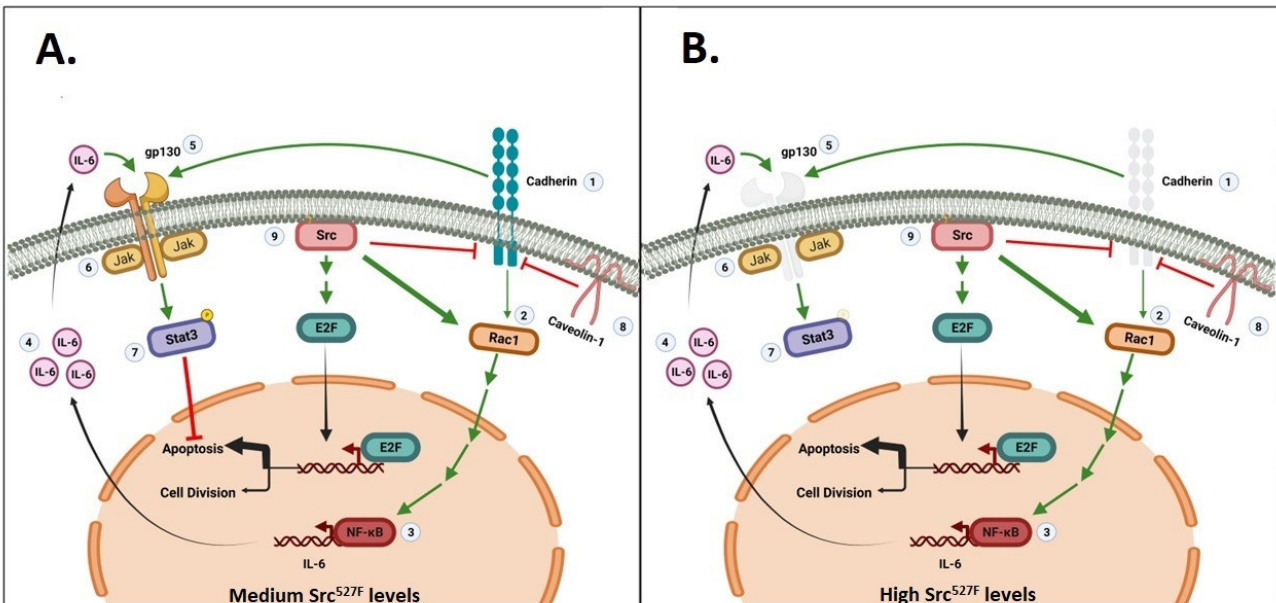
Figure 1. The engagement of cadherins from opposing cells increases Rac and Stat3 activity and is required for Src-mediated Stat3 activation and cellular survival (data from [48]). Engagement of cadherins (1) increases Rac (2) levels and activity, leading to Stat3 (7) activation through NFκB (3), IL6 (4), gp130 (5) and Jak (6). Caveolin-1 (8) reduces gp130 and Stat3-ptyr705 by binding to and sequestering cadherins into its scaffolding domain [50]. Src 527F (9) also increases Rac levels and activity, independent from cadherin engagement (see Figure 3A in Ref. [48]). What follows, and its effect upon Stat3, depends upon the levels of Src 527F expression: ( A ) medium Src 527F levels: activation of Rac leads to the secretion of IL6 family cytokines and the activation of gp130, Jak and Stat3 (see Figure 2B in Ref. [48]). At the same time, gp130 function requires cadherin engagement, but cadherins are downregulated by Src 527F . However, at medium Src 527F levels there is enough residual cadherin/gp130 so as to allow Stat3-ptyr-705 phosphorylation and activation (adapted from [45–48]). ( B ) High Src 527F levels: cadherin levels are reduced to nondetectable, and this leads to gp130 downregulation (see Figure 5A,B in Ref. [48]), with a dramatic reduction in Jak and Stat3 activities as a result (see Figure 2 in Ref. [48]). Generated in BioRender.